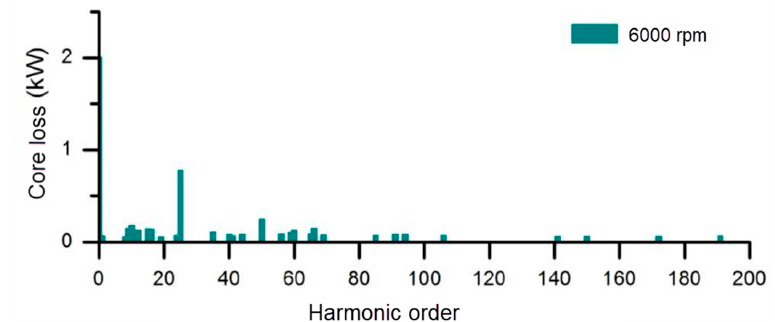
Figure 18. Stator core loss harmonics under SVPWM.